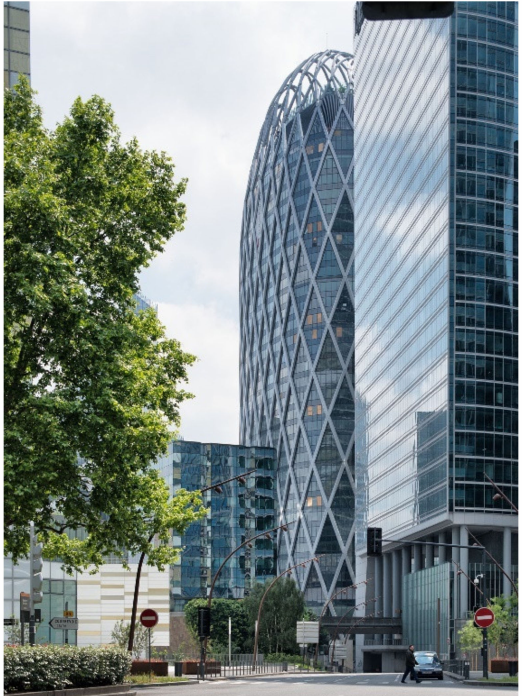
Figure 4. Tour D2, La D é fense, Paris (© Pierre Elie de Pibrac/Bechu & Associ é